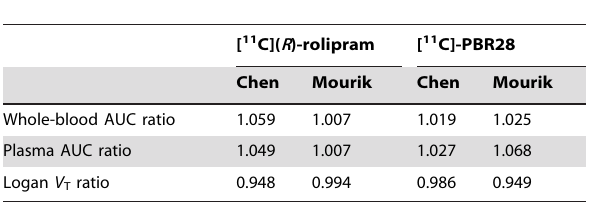
Table 4. Results of the phantom